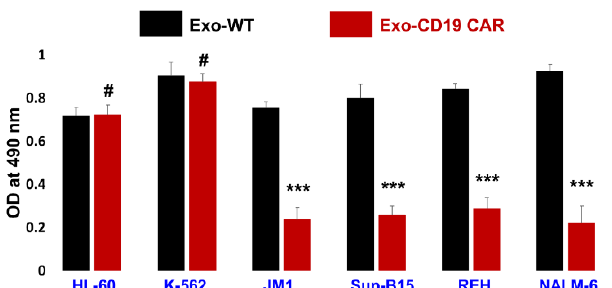
Figure 6. Cytotoxicity measurement by MTS assay. Exposure of Exo-WT and Exo-CD19 CAR on CD19-negative and CD19-positive cells. Exo-CD19 CAR exposure induced cytotoxicity in CD19- positive target cells (JM1, Sup-B15, REH, and NALM-6) while no cytotoxicity was observed in CD19-negative target cells (HL-60 and K-562). Combined data ( n = 3 independent experiments) demonstrating level of significance and reproducibility. P-value *** p < 0.001 and # demonstrate not significant ( p > 0.05). Black bar demonstrates Exo-WT treatment and red bar demonstrates Exo-CD19 CAR